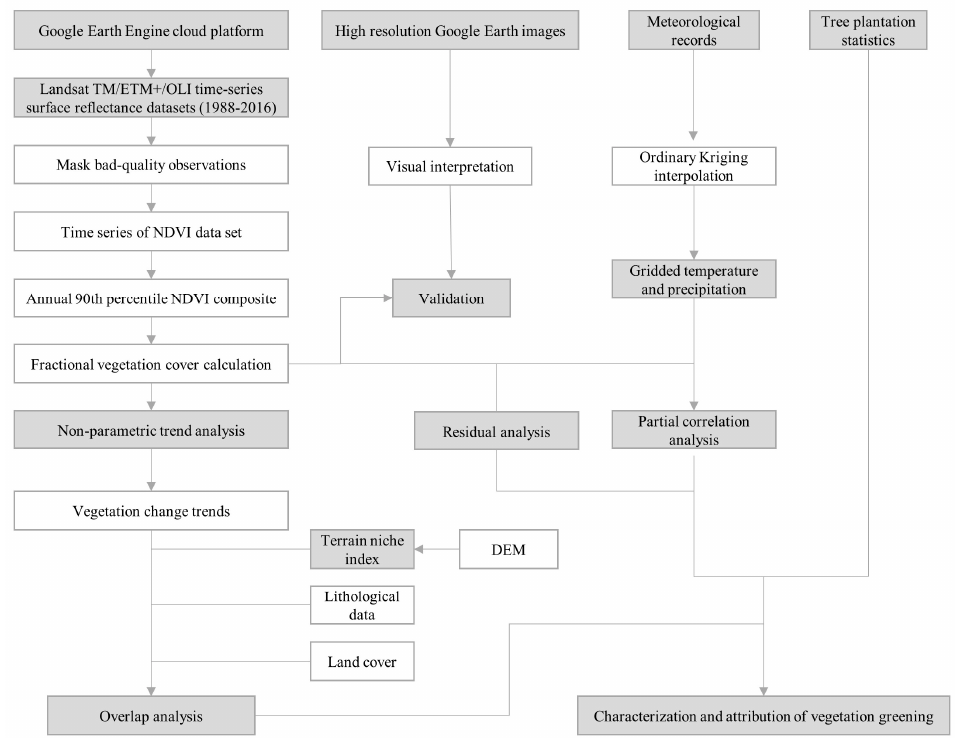
Figure 2. Workflow of detection and attribution of vegetation greening trends in two typical karst watersheds of Nandong and Xiaojiang in southwest China from 1988 to 2016.